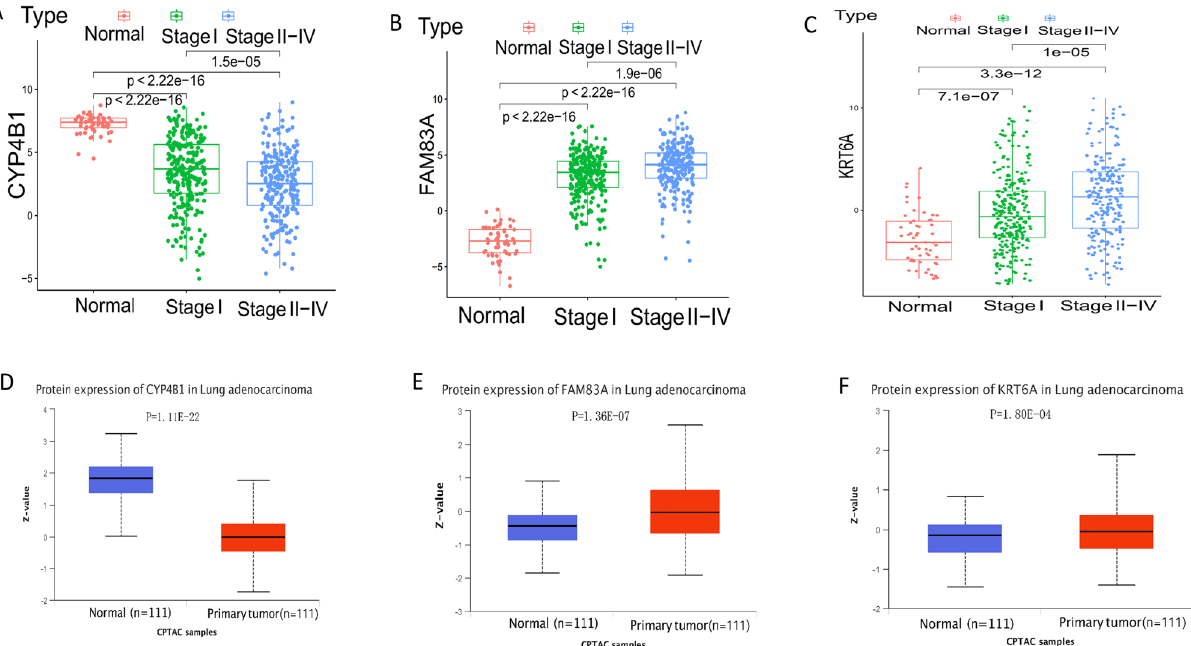
Figure 8. Prognosis and expression results of early diagnosis and prognosis genes in lung adenocarcinoma and other tumors. ( A – C ), CYP4B1 ( A ), FAM83A ( B ), and KRT6A ( C ) were expressed in the normal group, stage I, and stage II-IV groups. ( D – F ), The expression levels of CYP4B1, FAM83A, and KRT6A in normal and tumor groups were analyzed by using the CPTAC data set in UNLCAN